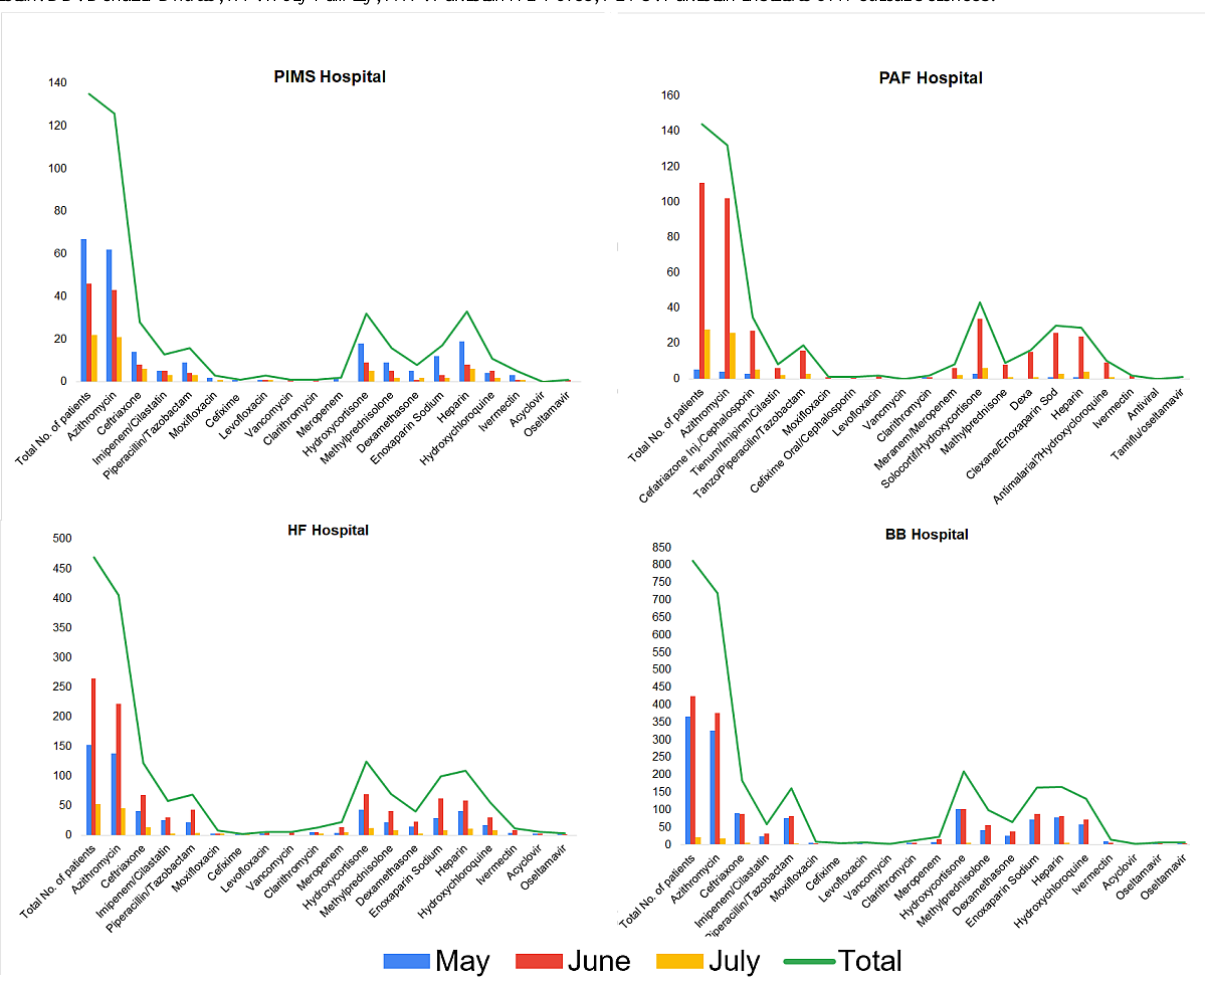
Figure 1. Hospital-wise relative distribution of different drugs administered to patients with COVID-19 during the first wave of the pandemic in